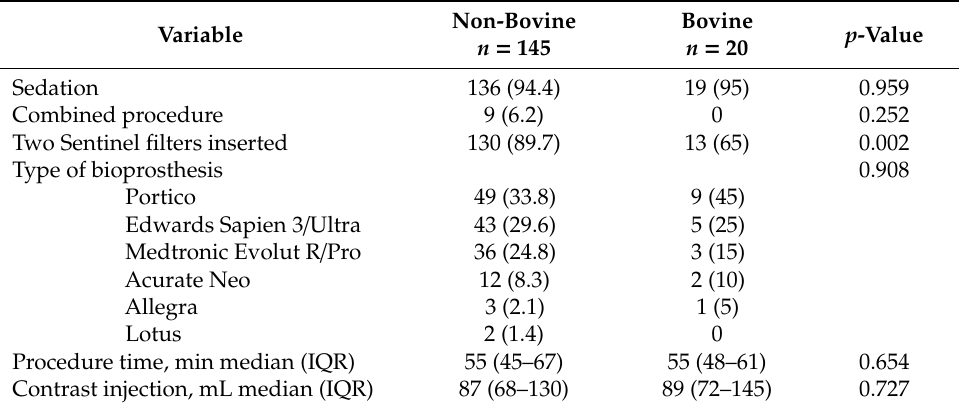
Table 2. Procedural